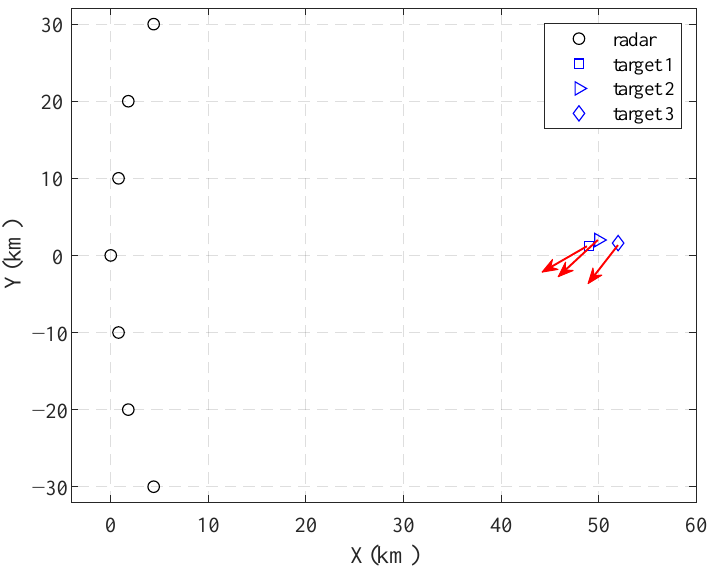
Figure 4. Placement of the MSRS and